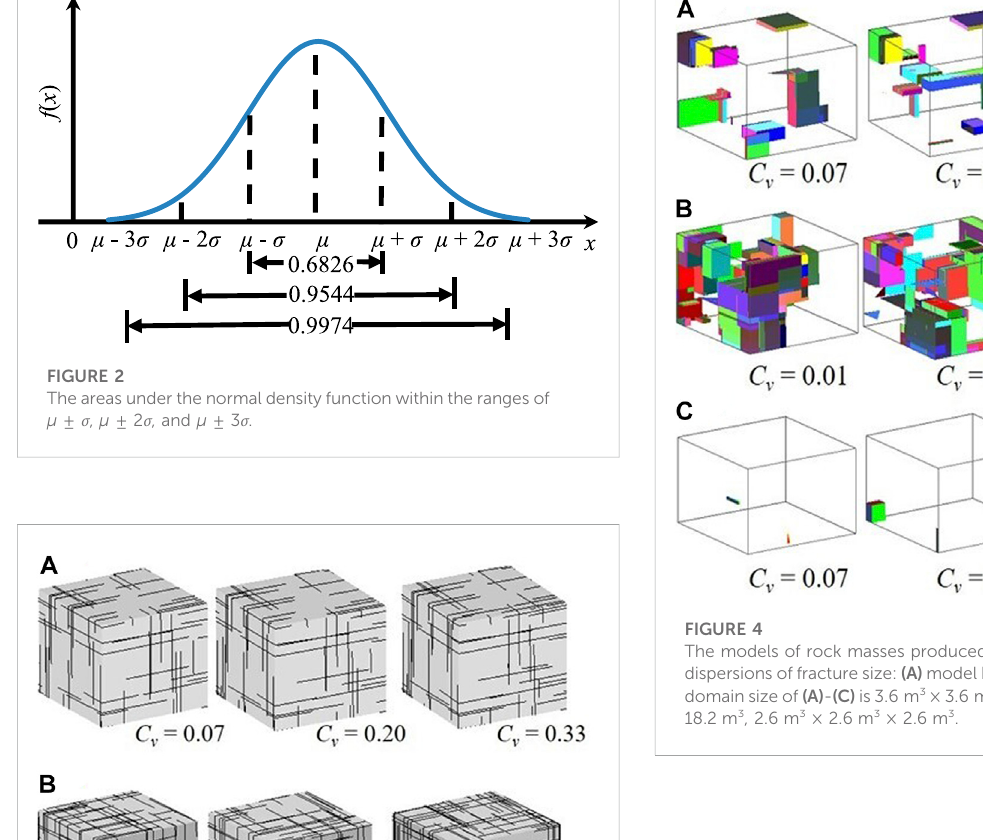
positive. For each model, fi ve different standard deviations were selected. The parameters of the discrete fracture networks are provided in Table 2, containing the fracture orientation, fracture occurrence, and standard deviations of fracture size. The representative fracture networks were obtained by statistical dispersions of different fracture sizes, as shown in Figure 3.